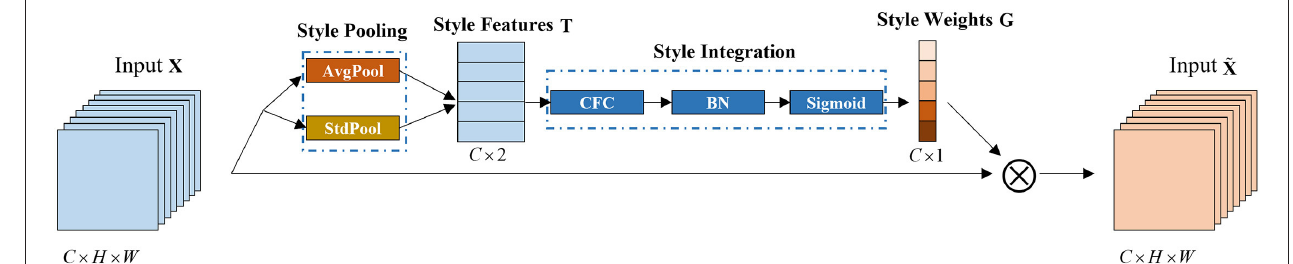
FIGURE 2 | SRM module. This module is mainly composed of two parts: style pooling and style integration. AvgPool refers to global average pooling, StdPool refers to global standard deviation pooling; CFC refers to the channel fully connected layer; BN refers to batch standardization.